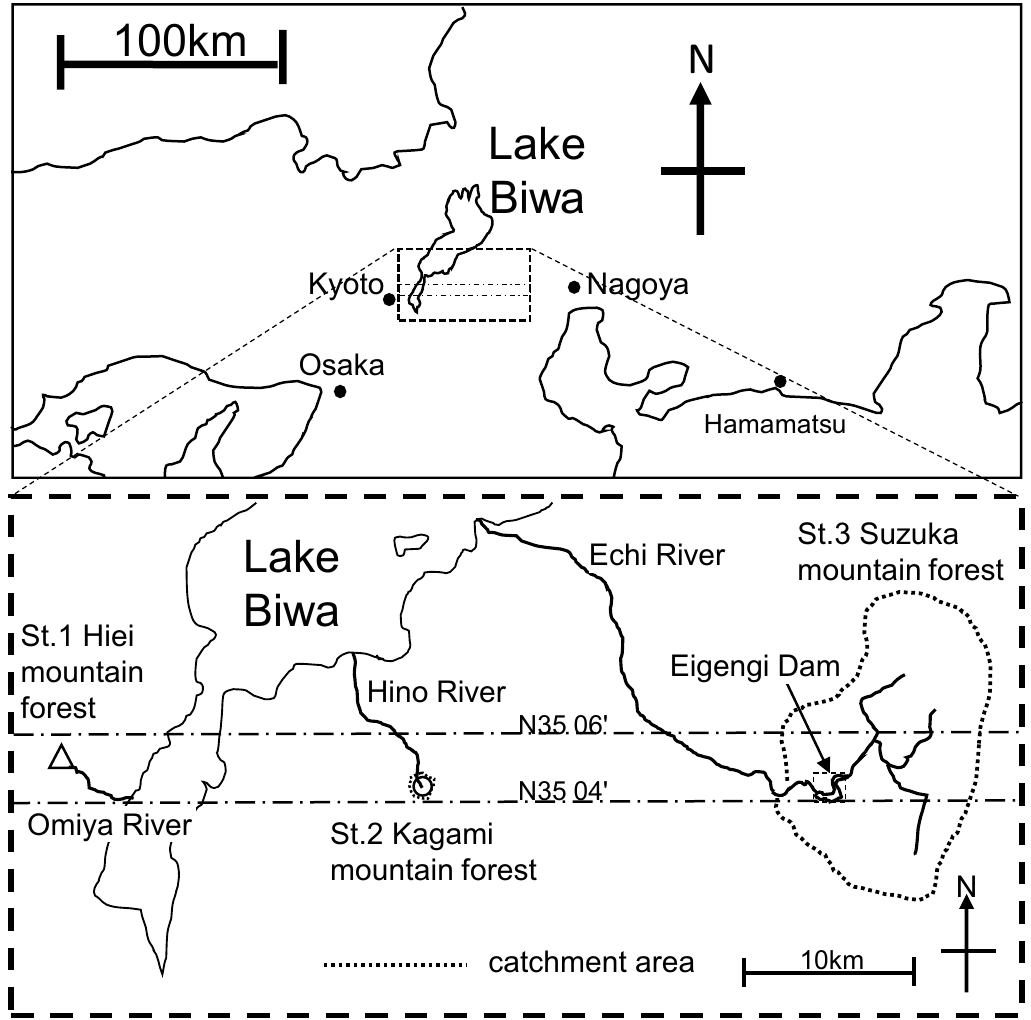
Figure 3. The location map of the field survey forest of the low mountain on granite are between N35 06’ from N35 04’, where are the basin of Lake Biwa near Kyoto in the western area of Japan. The location map was